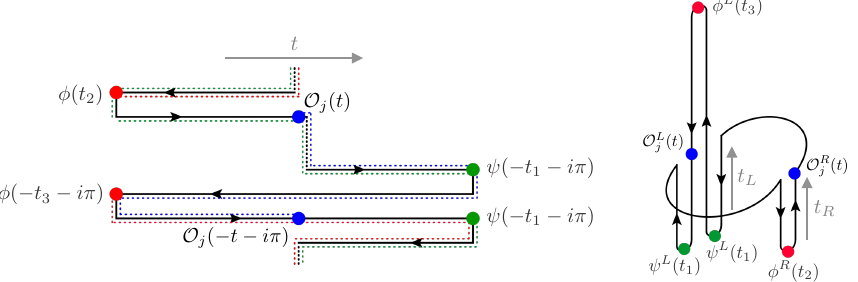
Figure 8 . Six-point configuration for the traversable wormhole setup. The blue operators corre- spond to the insertions of O L ( t ) O R ( t ) whose exponential can make the wormhole traversable. The j j ‘signal’ φ corresponds to the red insertions. The ‘perturbation’ ψ L ( t